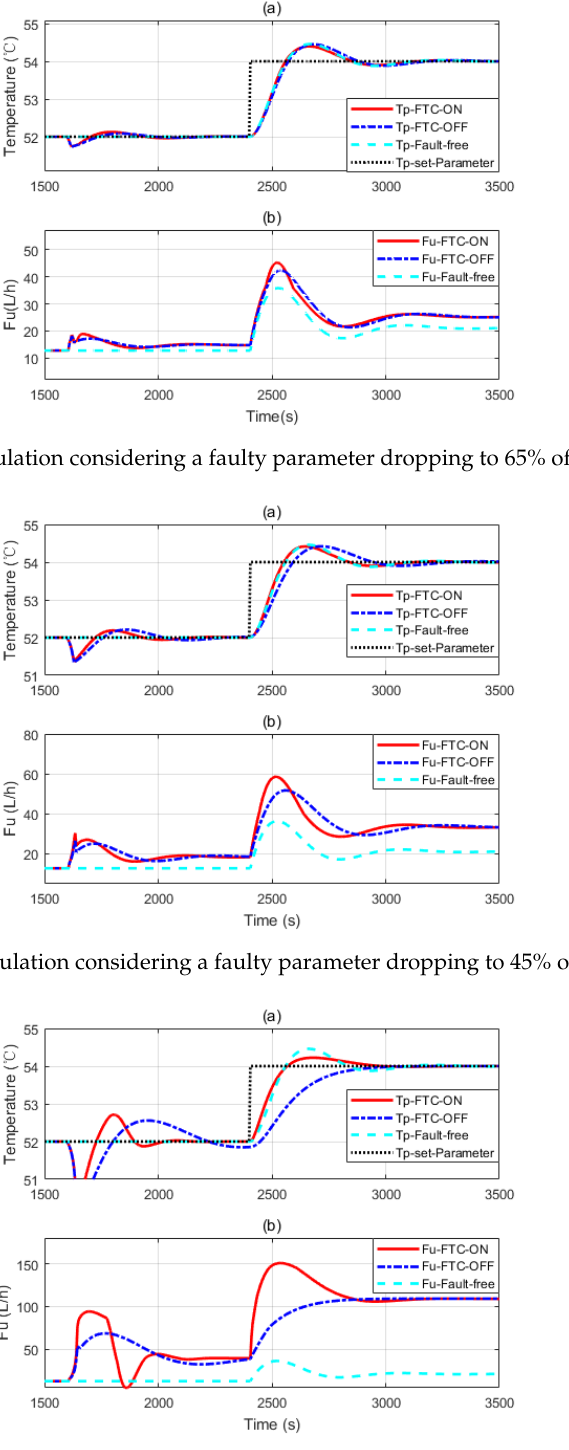
Figure 11. ( a , b ) The simulation considering a faulty parameter dropping to 18% of its nominal